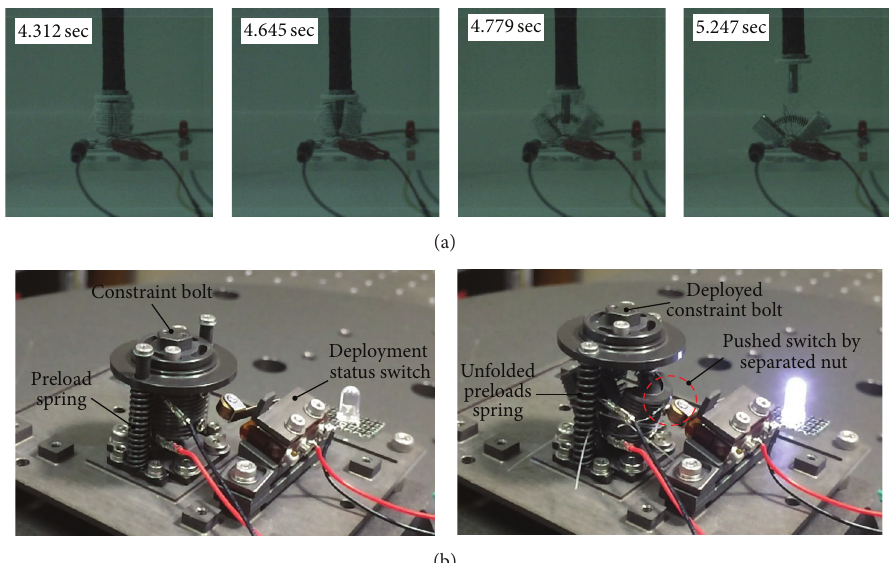
Figure 4: Nonexplosive hold-down and release mechanism (HRM).